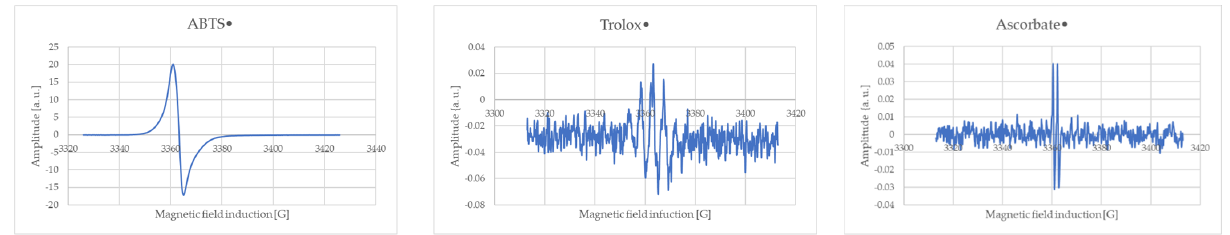
Figure 11. ESR spectra of ABTS • , Trolox and ascorbate radicals recorded after treatment of ABTS • solution with excess of Trolox and ascorbic acid, respectively.